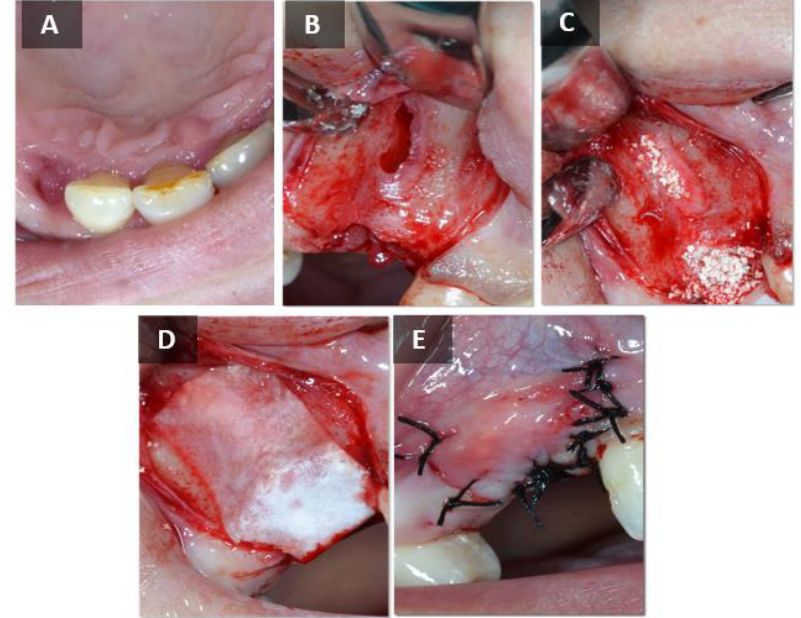
Figure 9. Surgical procedure—control group. ( A ) Hopeless tooth. ( B ) Alveolus and bone defect after tooth extraction. ( C ) Placement of the BSB. ( D ) Placement of the resorptive membrane. ( E ) Sutured wound.